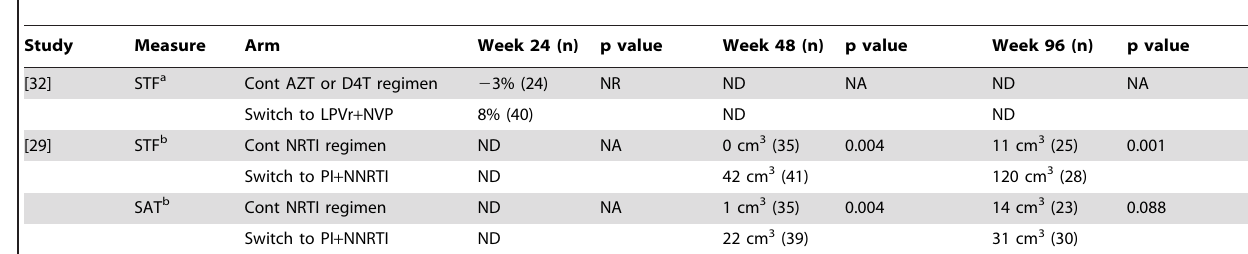
Table 17. Switching studies: change from baseline in subcutaneous thigh fat (STF) and subcutaneous adipose tissue (SAT) on CT scan: NRTI-containing regimens versus NRTI-sparing regimens.